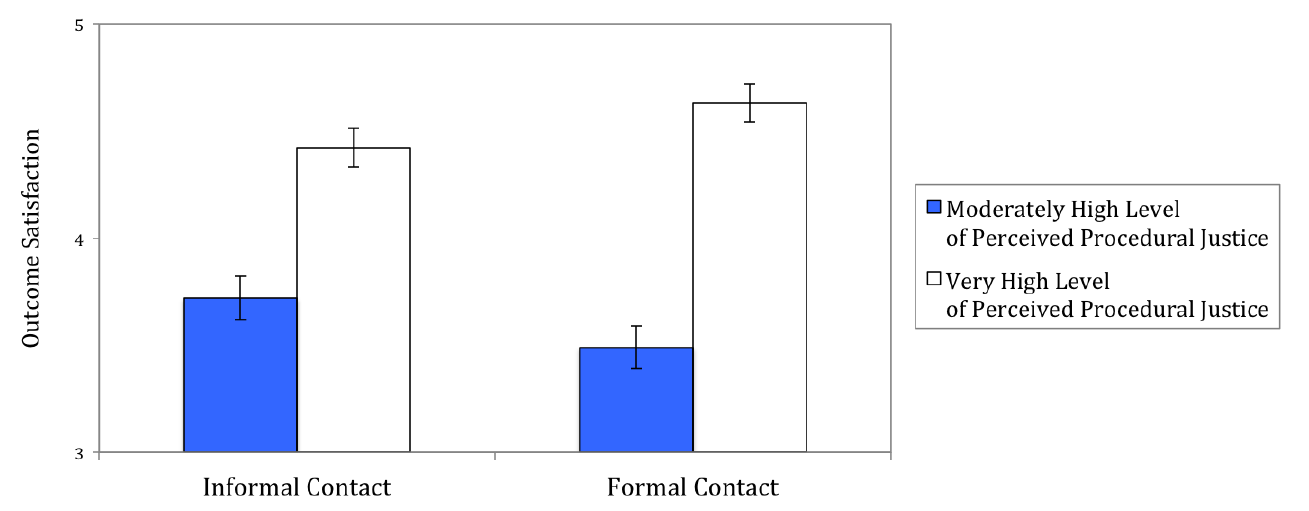
Figure 7 . Citizen satisfaction with outcomes as a function of experienced procedural justice (moderately high level [-1 SD ] versus very high level [+1 SD ]) and informal contact within the Fair Tracks programme or formal contact within regular, formal procedures. Scores are on 5-point scales with higher values indicating higher scores of outcome satisfaction. Error bars represent standard errors of the mean.